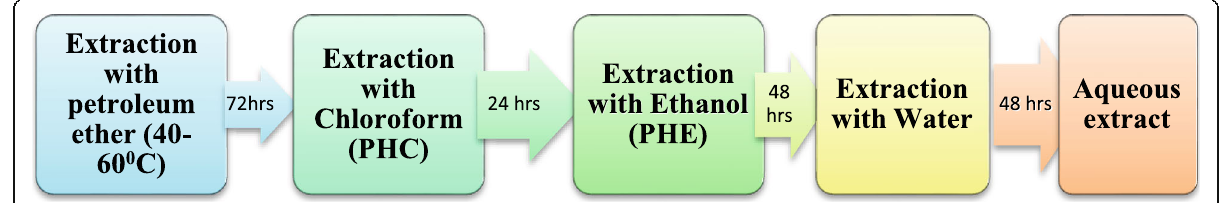
Fig. 1 Successive solvent extraction procedure for Peganum harmala